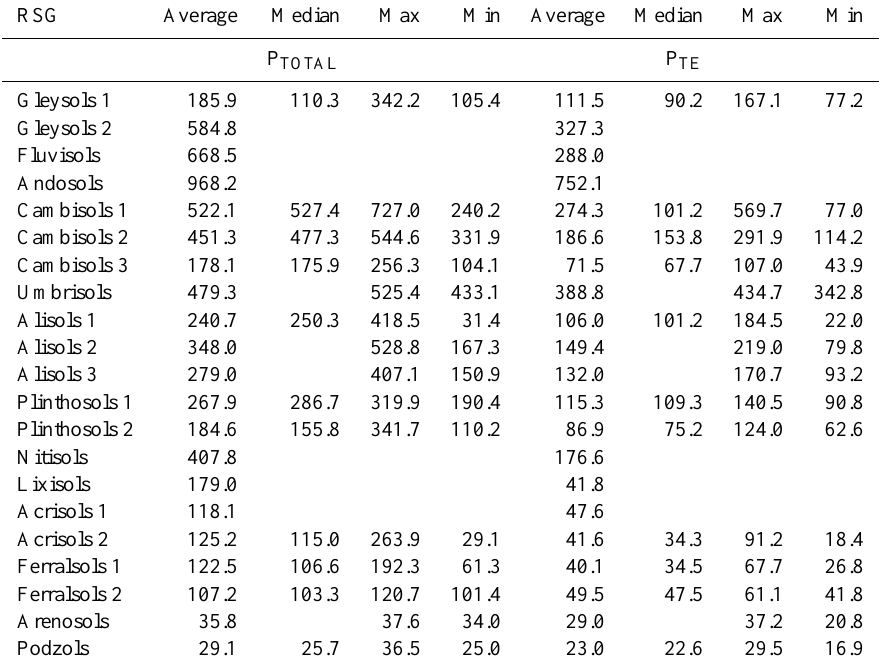
Table 4. Average values, median and range of variation, of total extractable P and P total for each Reference Soil Group and lower classifi- cation